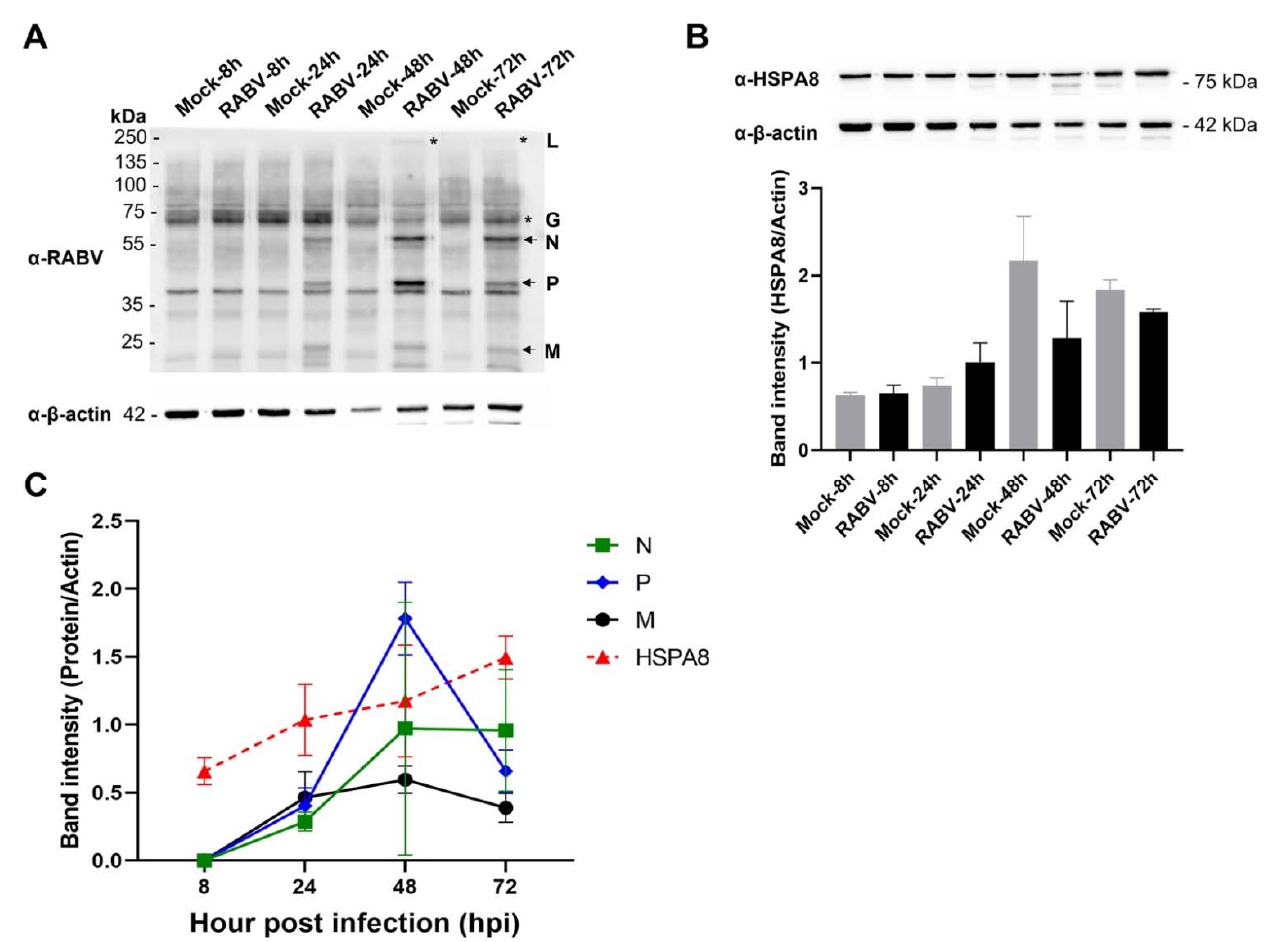
Figure 8. A dynamic change of RABV and HSPA8 proteins in infected hiPSC-derived neurons. Protein samples of mock and RABV-infected neurons were subjected to Western blot analysis. The membranes were probed with ( A ) horse α -RABV serum and ( B ) mouse α -human HSPA8 antibodies to detect RABV and HSPA8 proteins, respectively. β -actin was used as the internal loading control. ( C ) The intensity of RABV N, P, M, and HSPA8 in the infection group was normalized with β -actin using an image analysis program. * Note that RABV G and L proteins were excluded from the analysis due to nonspecific bands presented at the same size as RABV G, masking the RABV G and faint bands of RABV L. Error bars represent means of band intensity ± standard deviation of duplicates.